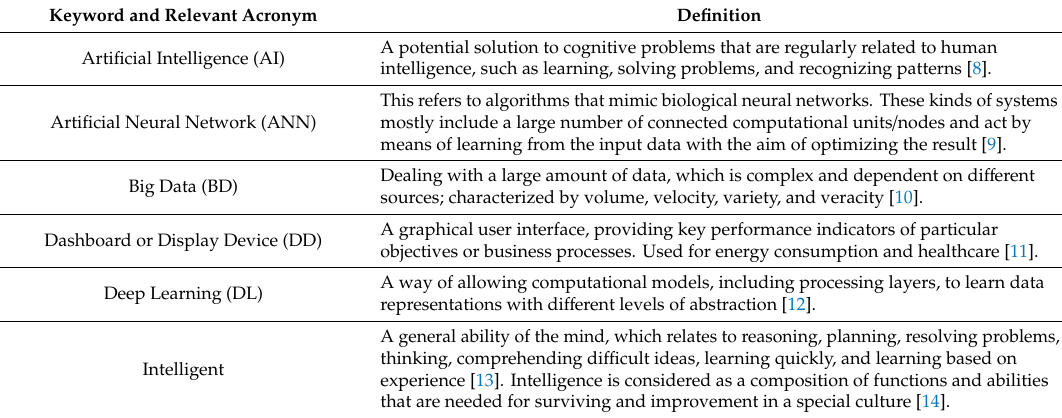
Table 1. Key terms and concepts of smart home and the relevant